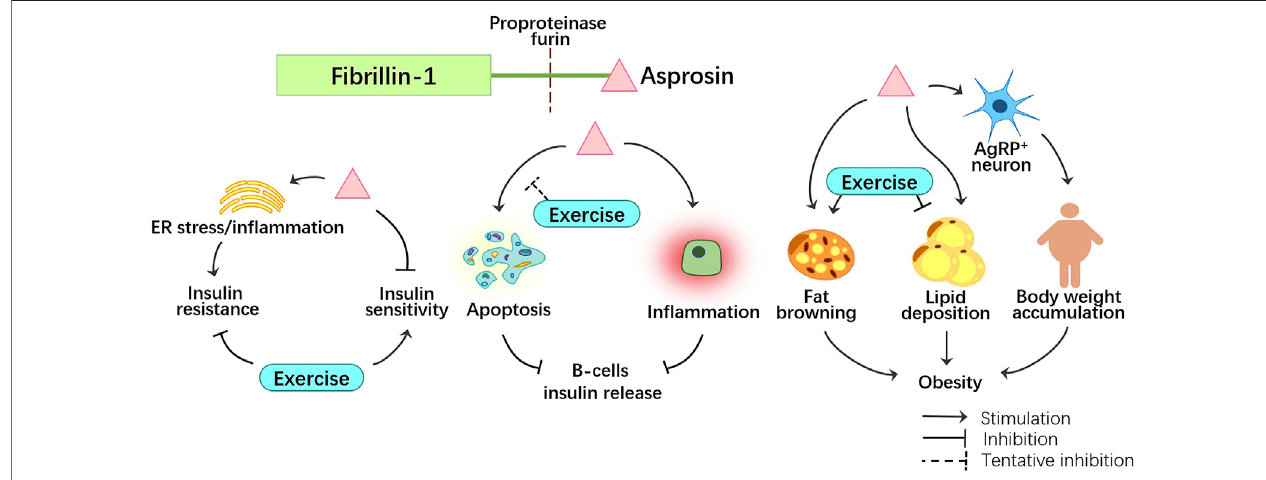
FIGURE 4 | The role of asprosin in metabolic disorders, such as insulin resistance, decreased insulin release and obesity. Exercise plays an inhibitory role to asprosin, helping to mitigate metabolic disorders.